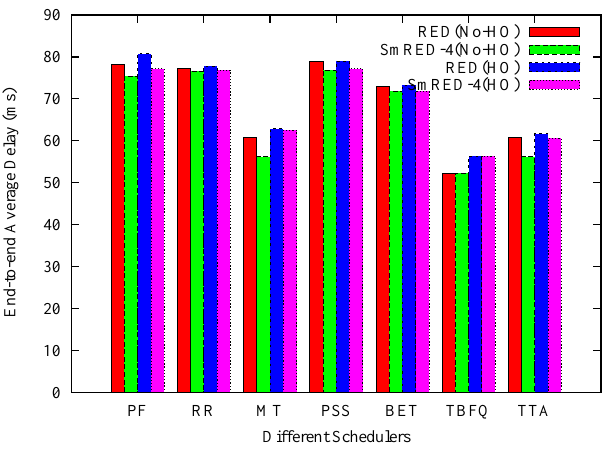
Figure 11. End-to-end average delay of different